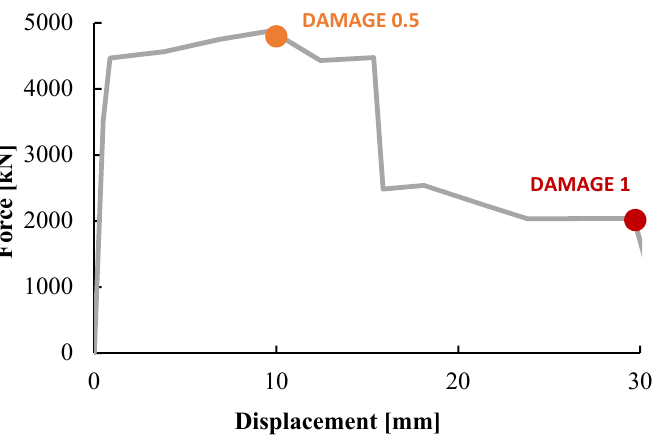
Figure 4. Capacity curve of the local element (RC column shown in Figure 5).